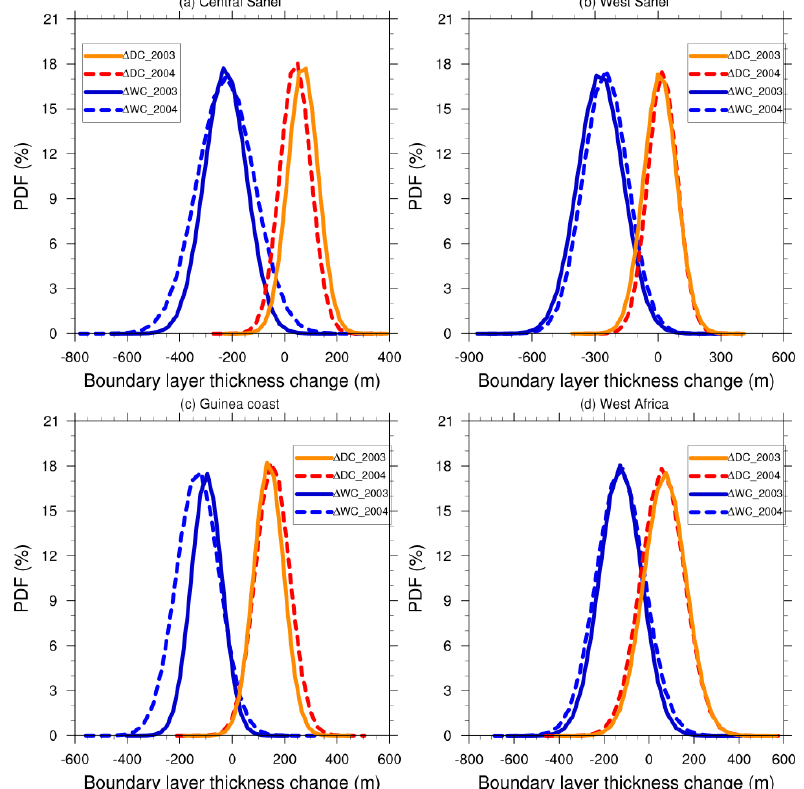
Figure 19. Same as Fig. 13 but for the height of the planetary boundary layer (in m).